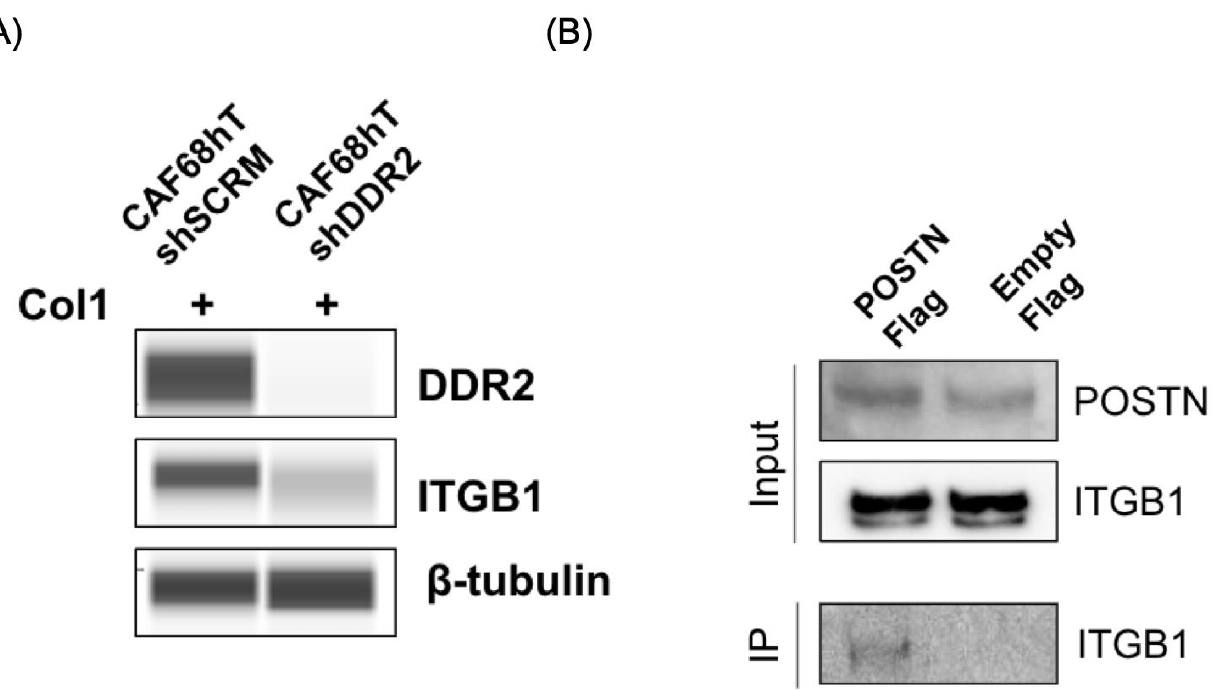
Figure 5. DDR2 regulates ITGB1, which is a direct binding partner of POSTN. ( A ) Immunoblot showing decreased ITGB1 expression in DDR2-depleted CAFs, ( B ) Co-immunoprecipitation of ITGB1 using FLAG-tagged POSTN and empty control constructs.